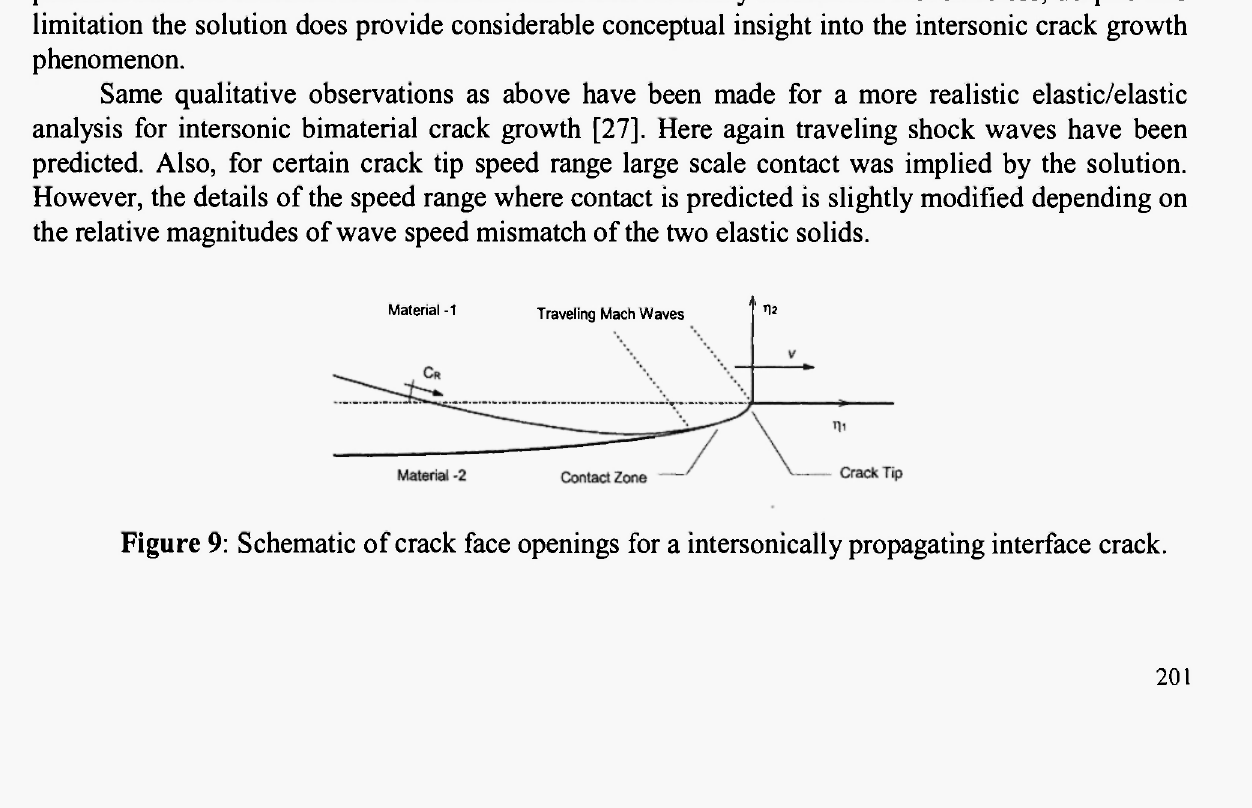
Figure 9: Schematic of crack face openings for a intersonically propagating interface